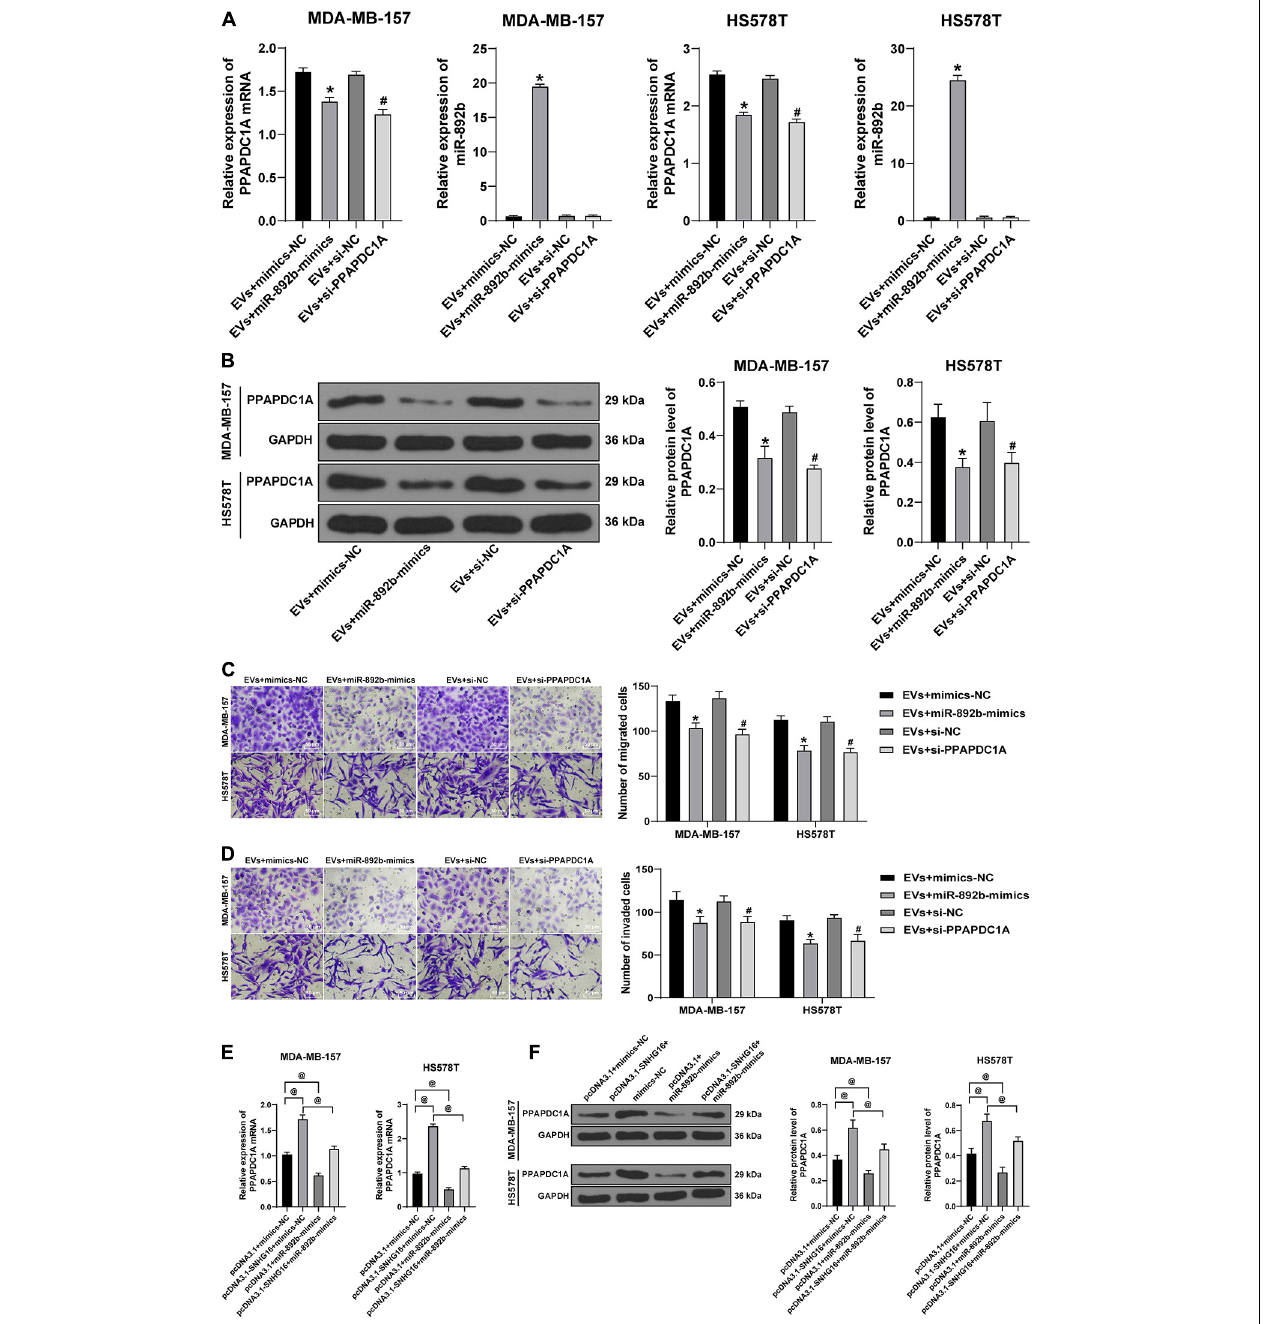
FIGURE 6 | SNHG16 carried by EVs promoted migration and invasion BC cells by inhibiting miR-892b and upregulating PPAPDC1A. MDA-MB-157 and HS578T cells were transfected with miR-892b-mimic or si-PPAPDC1A, followed by MDA-MB-231 cell-EVs treatment. (A) The miR-892b and PPAPDC1A expression in MDA-MB-157 and HS578T cells was detected using RT-qPCR. (B) The PPAPDC1A protein level in MDA-MB-157 and HS578T cells was detected using Western blotting. (C,D) The migration and invasion of MDA-MB-157 and HS578T cells were measured using Transwell assays. MDA-MB-157 cells and HS578T cells were treated with pcDNA3.1-SNHG16 and miR-892b-mimic. (E) PPAPDC1A mRNA expression in cells was detected using RT-qPCR. (F) PPAPDC1A protein level in cells was detected using Western blotting. Cell experiment was repeated three times. Data were presented as mean ± standard deviation. Data in A and B were analyzed using one-way ANOVA, and data in C and D were analyzed using two-way ANOVA, followed by Tukey’s multiple comparison test, * p < 0.05 vs. EVs + mimic-NC group, # p < 0.05 vs. EVs + si-NC group; @ p < 0.05.